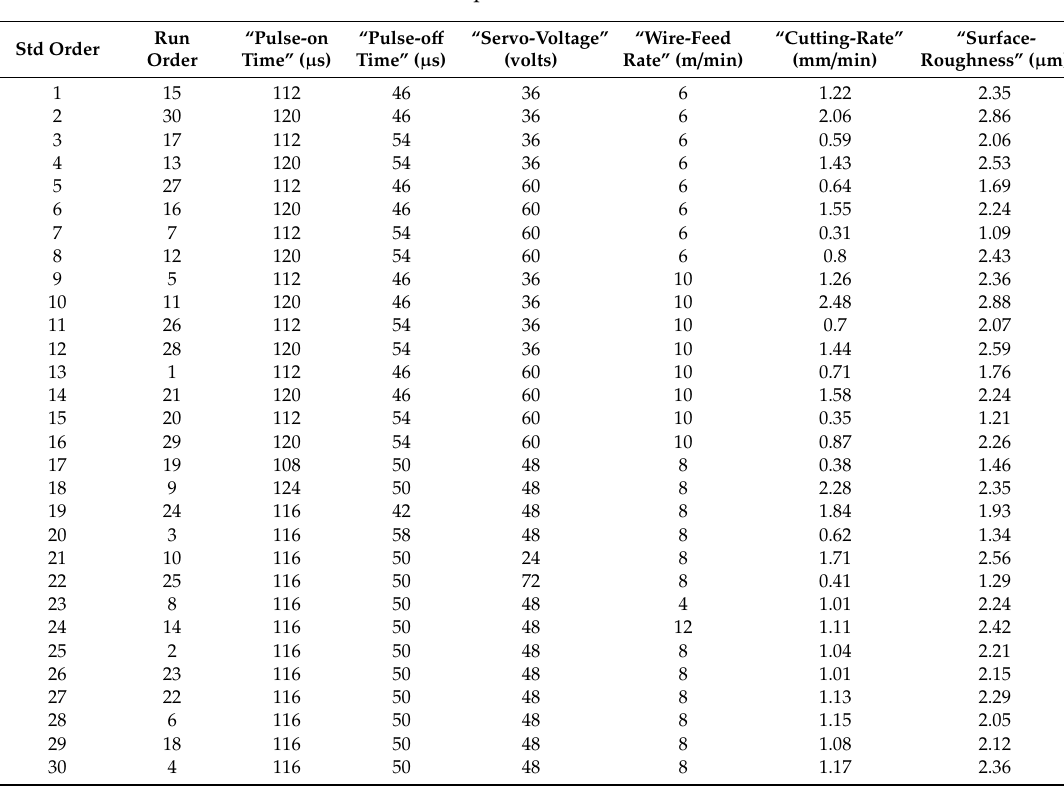
Table 4. Experimental